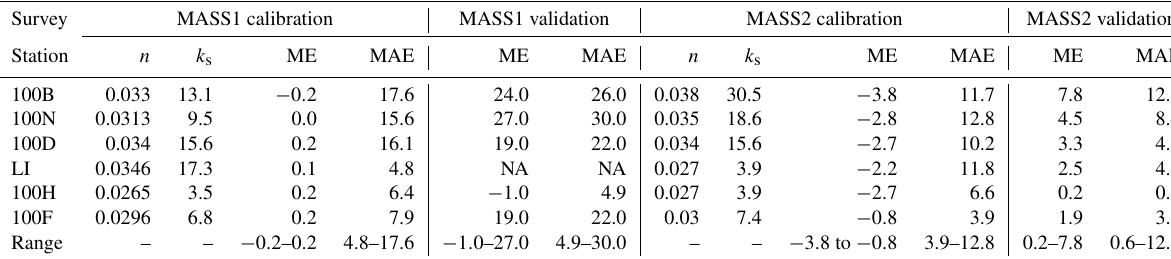
Table A3. Roughness parameters used in MASS1/2 and associated model